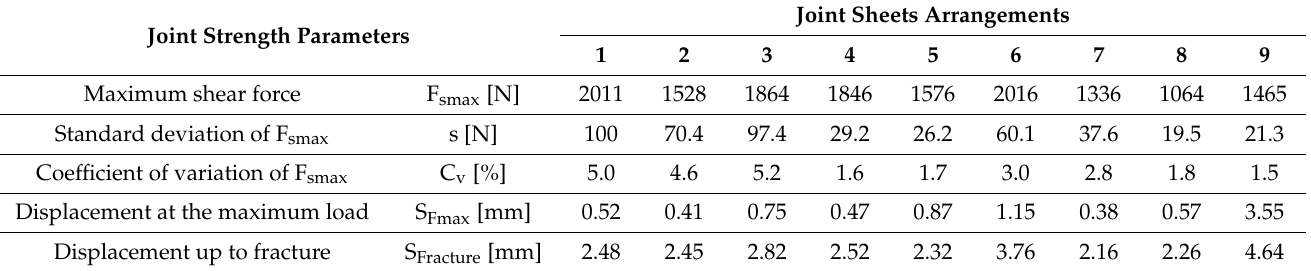
Table 3. Parameters of joint strength from tensile shear test.